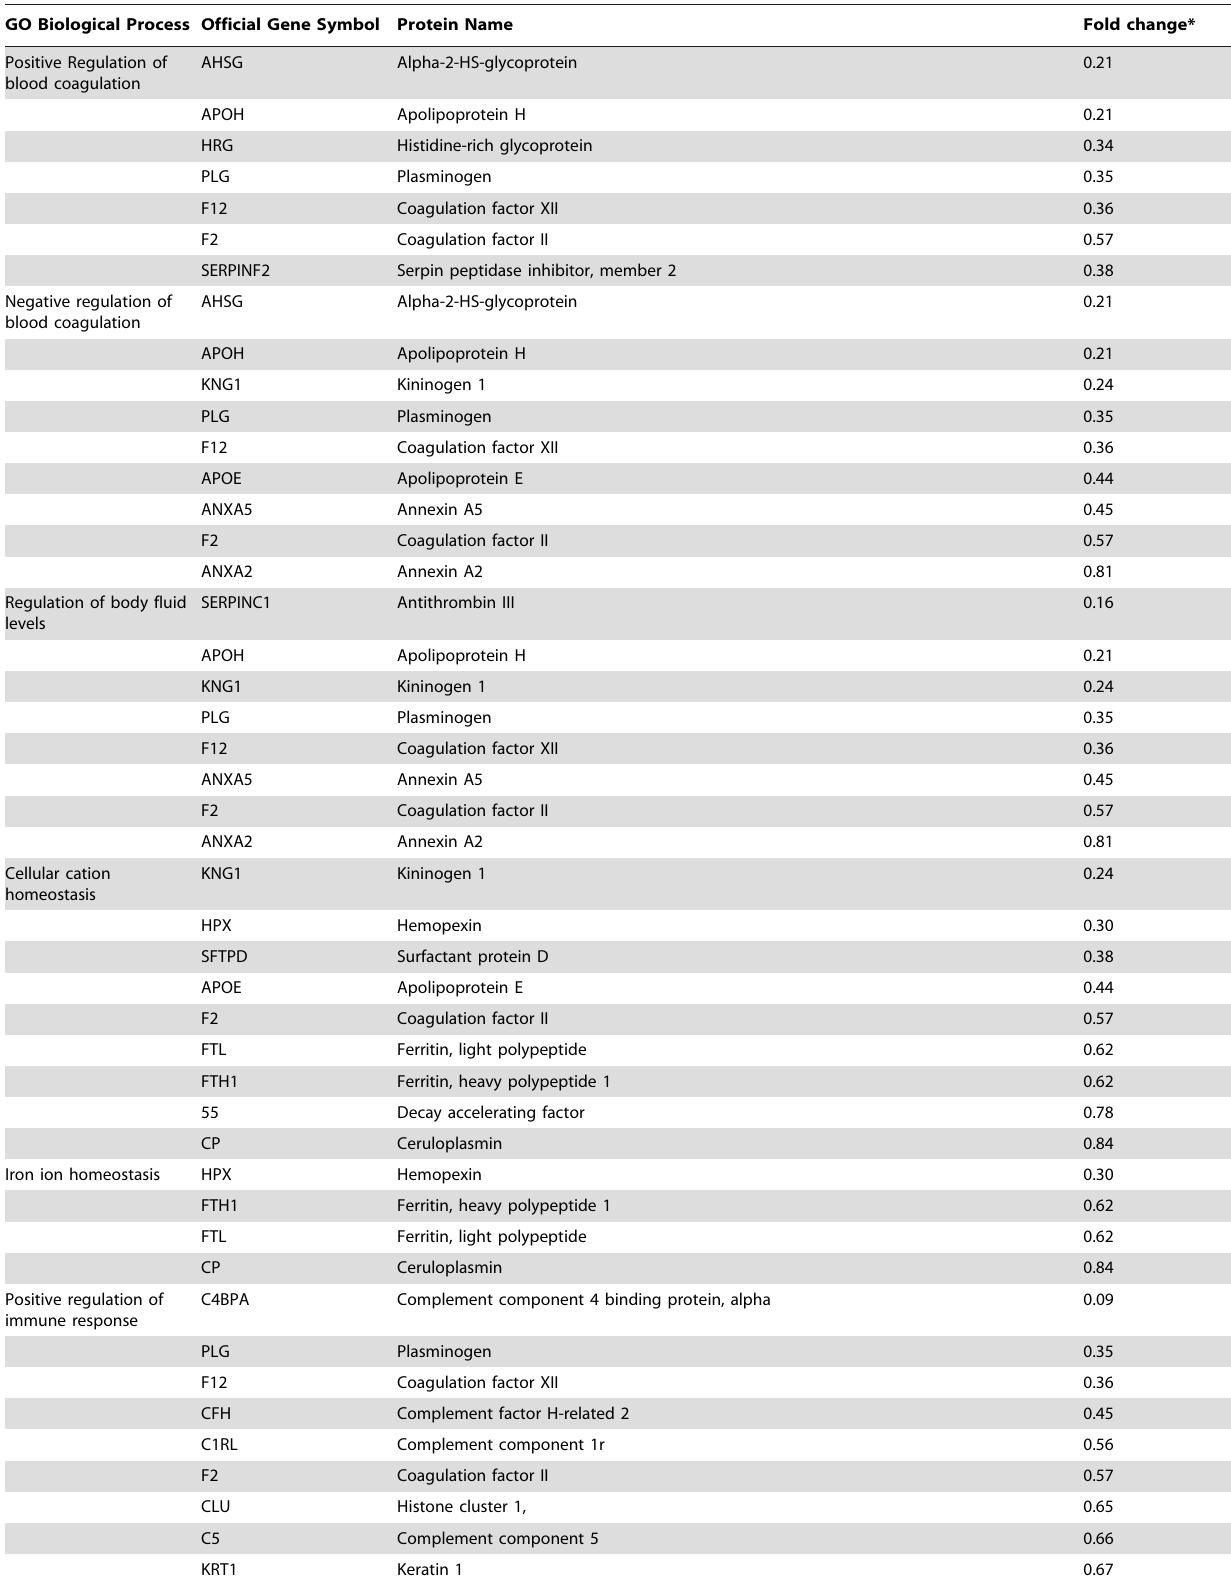
Table 3. Early-phase ARDS Survivor Ontology Groups and Associated